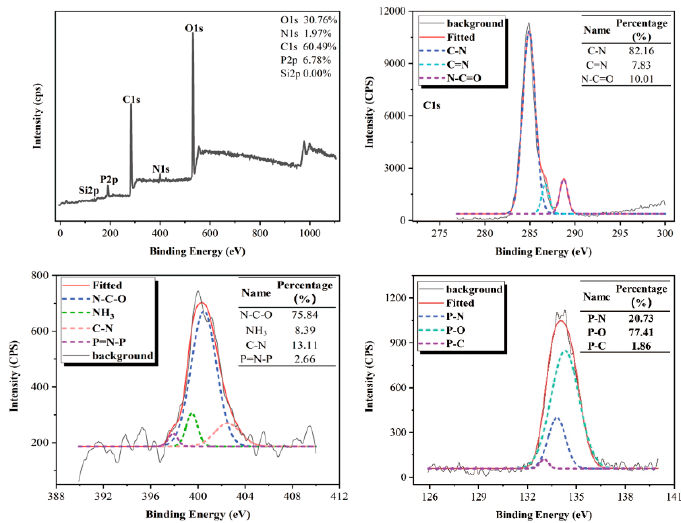
Figure 11. XPS spectra of the char layer of HPN-EPPA -UR-PA resin (Formula E).